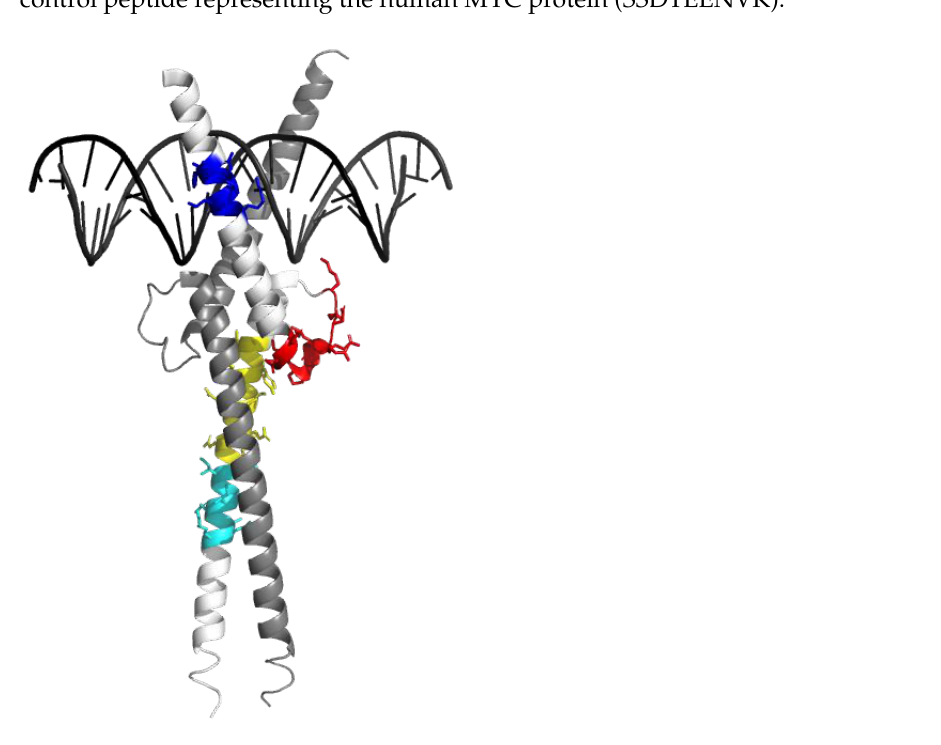
Figure 1. Reporter peptides are indicated on the tridimensional structure of Omomyc. Crystal structure of Omomyc (PDB ID 5I50.pdb) [9]. The reporter peptides used in this study are highlighted within the structure in blue (THNVLER), red (DQIPELENNEK), yellow (ATAYILSVQAETQK), and cyan (LISEIDLLR).